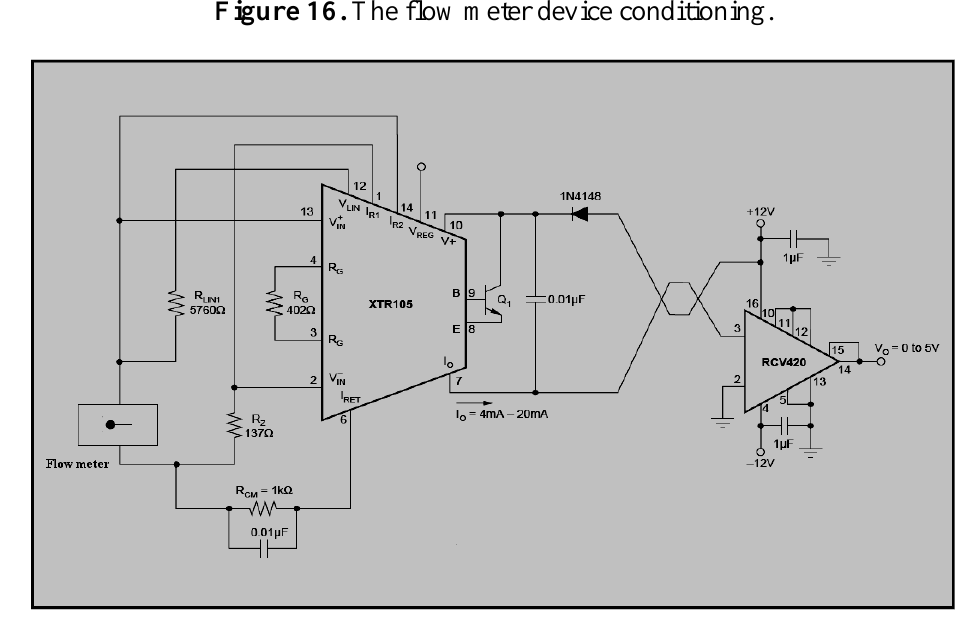
Figure 16. The flow meter device